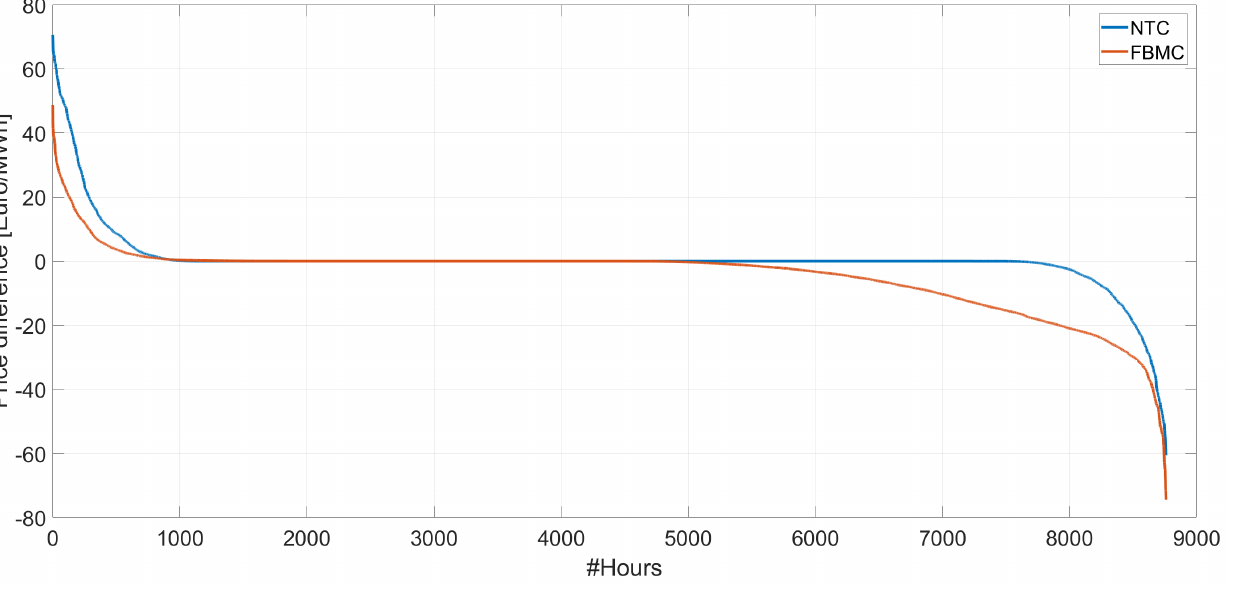
Figure 13. Annual duration curve of the price difference between Germany and Belgium.